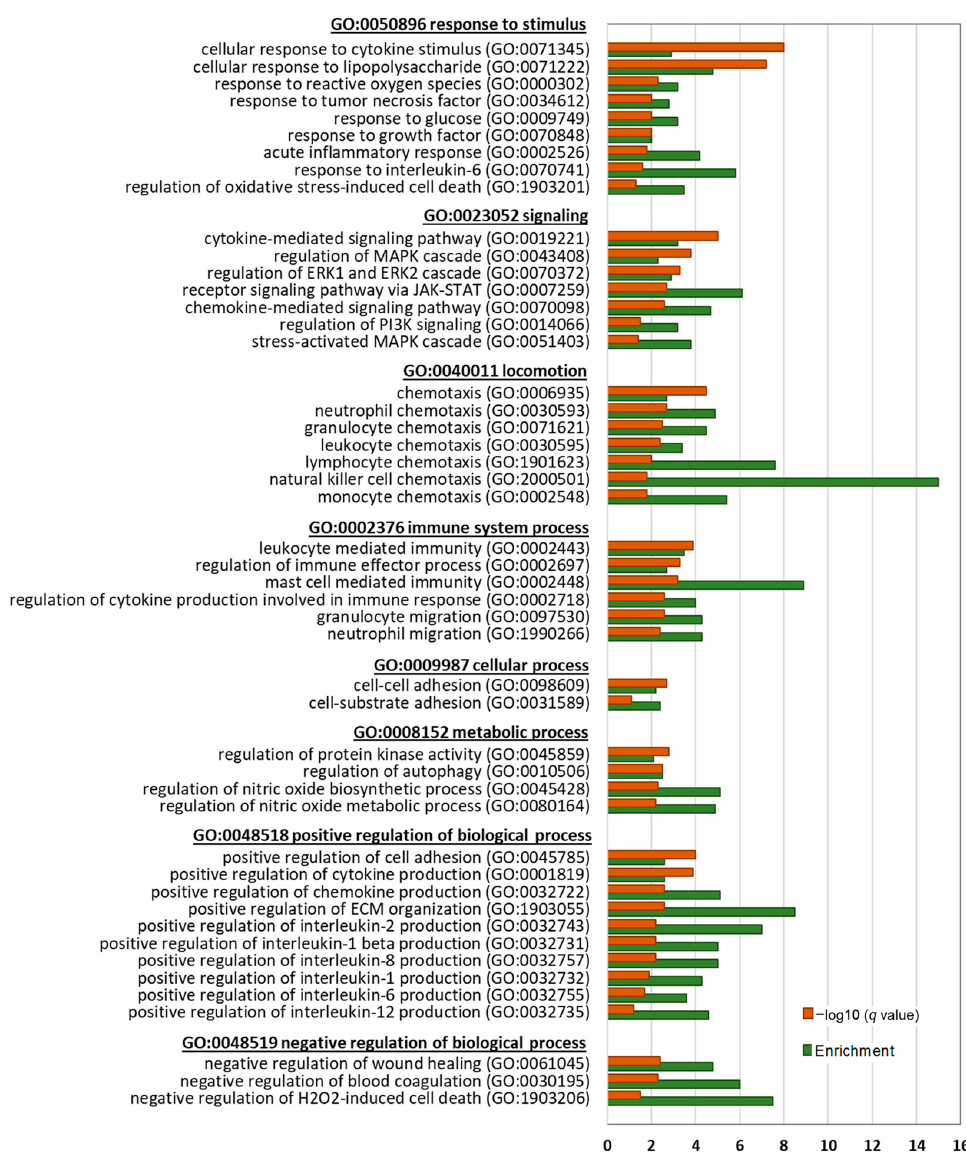
Figure 6. Biological process gene ontology (GOBP) analysis of downregulated DEGs between BTEE- treated and nontreated RAW264 cells after 17 h LPS stimulation. Top enriched GOBP terms are pre- sented under their parent terms. The orange bars represent the − log10 q value (Benjamini–Hochberg adjusted p value for multiple comparisons), and the green bars represent the enrichment score.